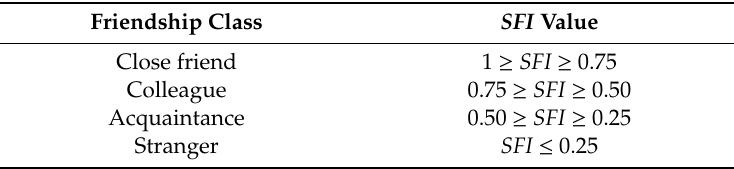
Table 2. SFI values for di ff erent friendship